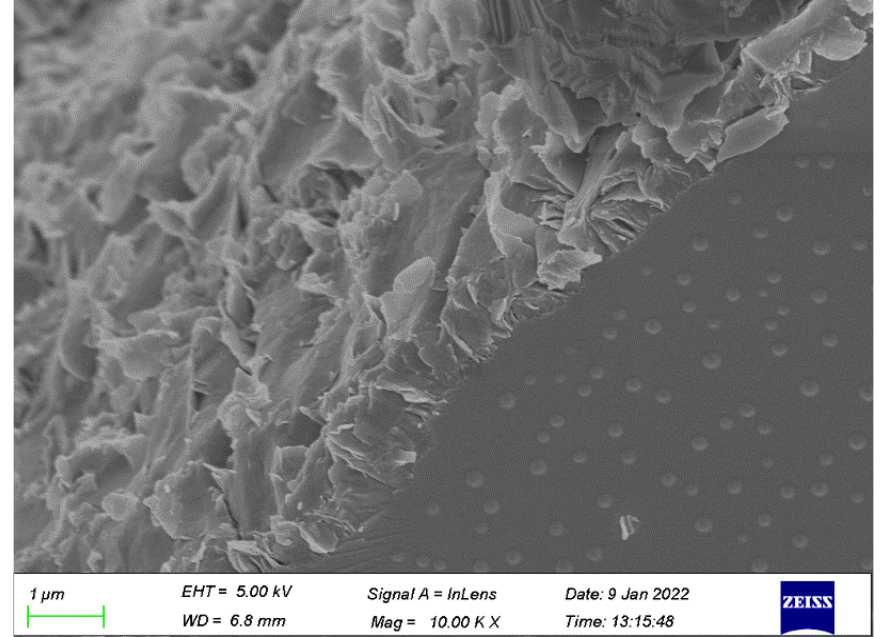
Figure 8. The ITZ of NS–GPC.